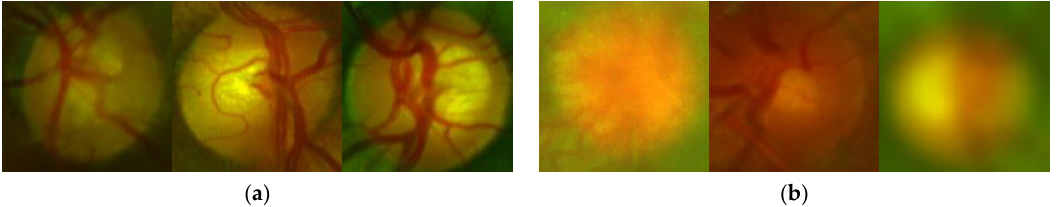
Figure 6. Examples of the ODs with good quality ( a ) and inadequate quality ( b ).